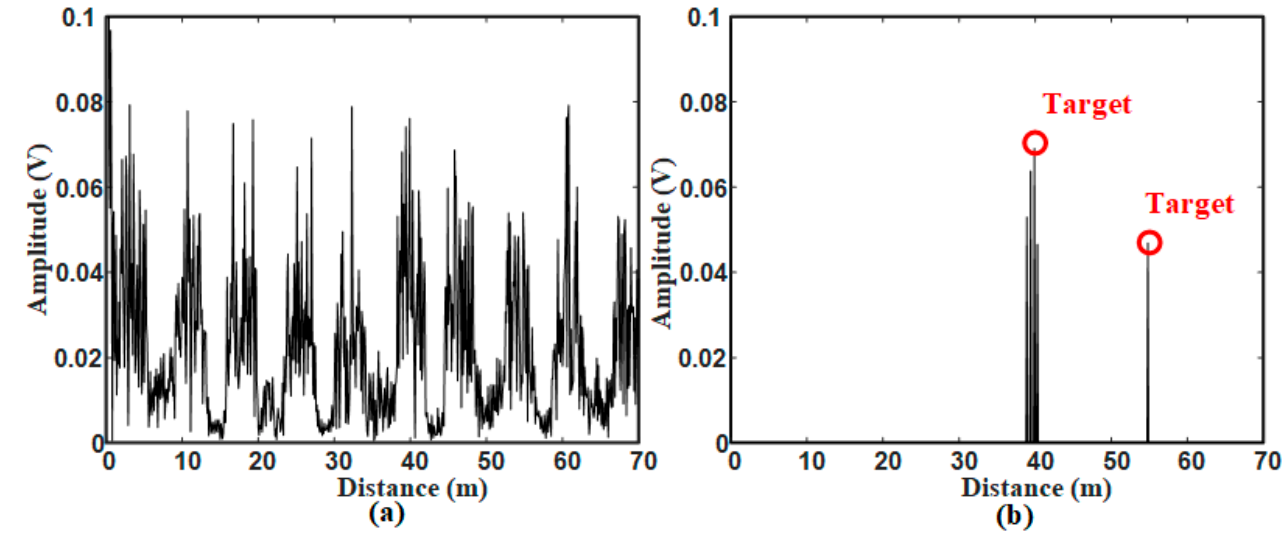
Figure 15. Signals in scene 2: ( a ) Original signal; ( b ) Target detection result.